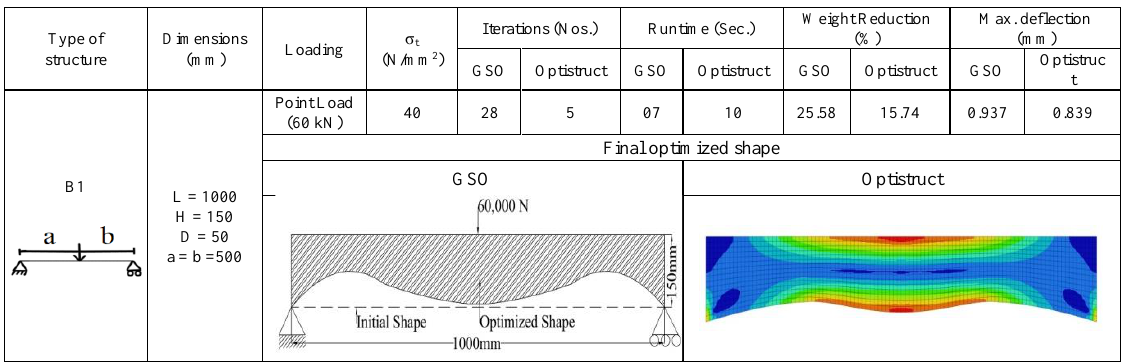
Table 1. Parameters for B1 with iterations, runtime and percentage weight reduction to reach the optimized shape.